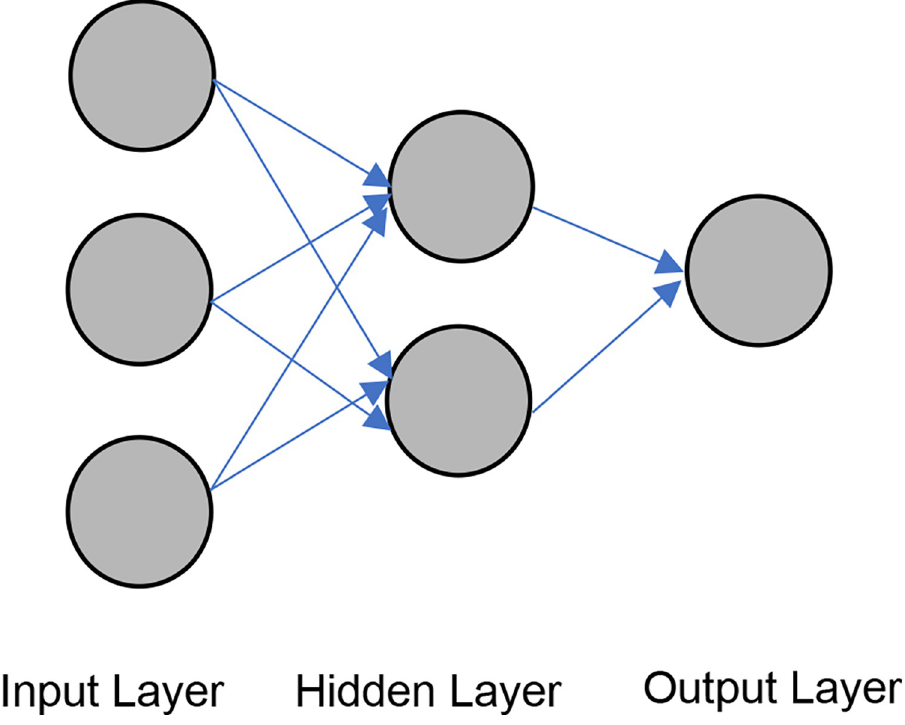
Fig 5. Layers of neural